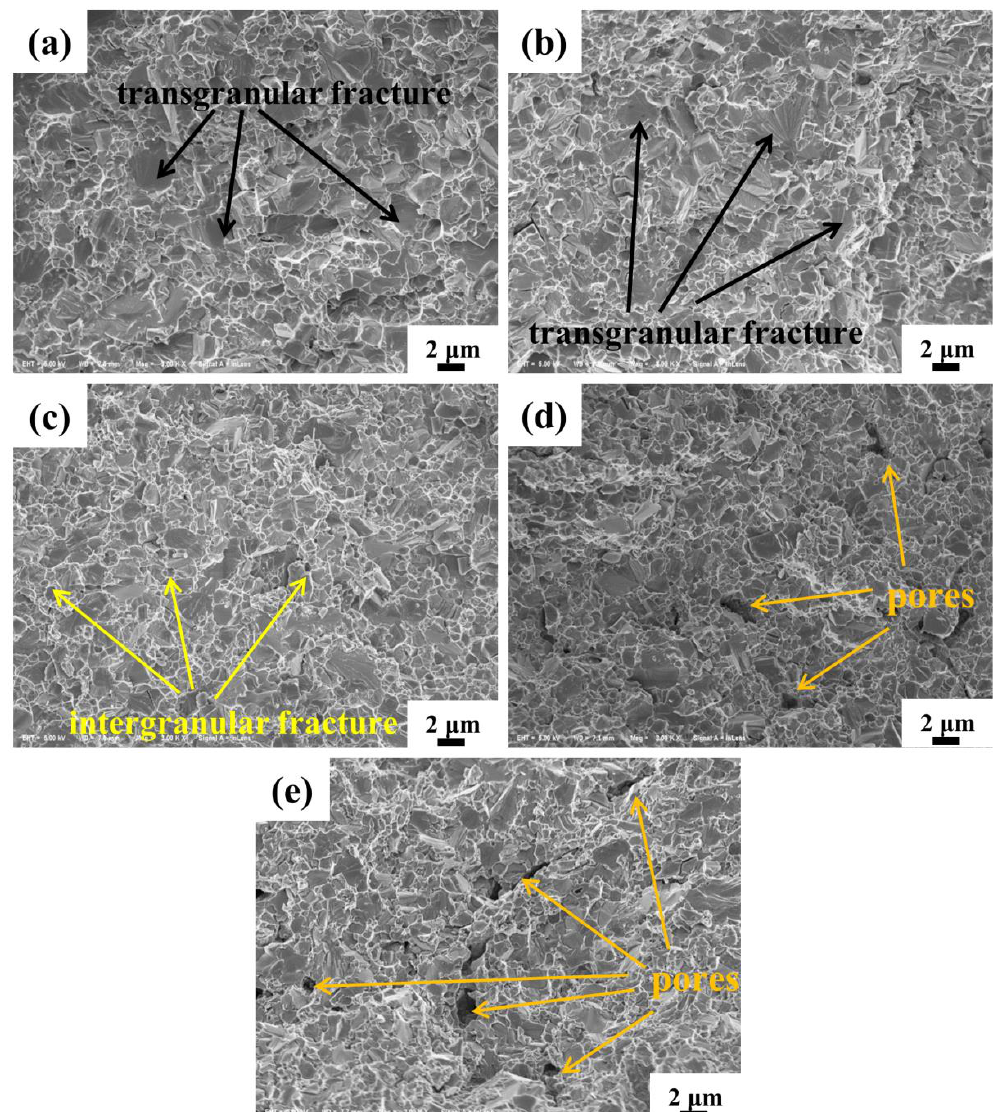
Figure 7. Fracture surface of Ti(C,N)-based cermets with different SiC p content: ( a ) 0.0 wt.%; ( b ) 1.0 wt.%; ( c ) 2.0 wt.%; ( d ) 2.5 wt.%; ( e ) 3.0 wt.%. ( b ) 1.0 wt.%; ( c ) 2.0 wt.%; ( d ) 2.5 wt.%; ( e ) 3.0